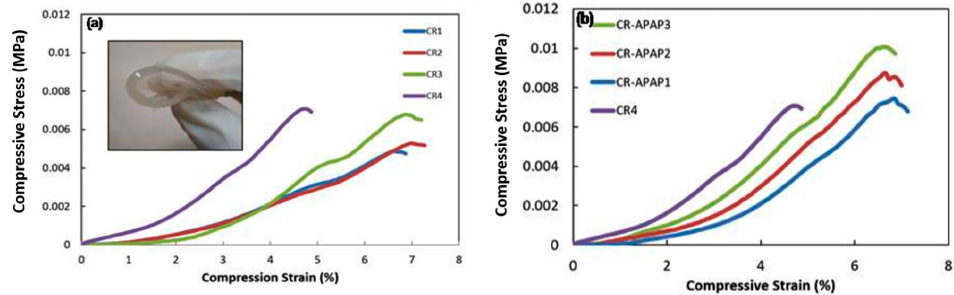
Fig. 1. (a) Stress-strain curves of CR hydrogels and (b) Stress-strain curves of CR-APAP Table 1. The compressive stress, strain and modulus of all samples Samples